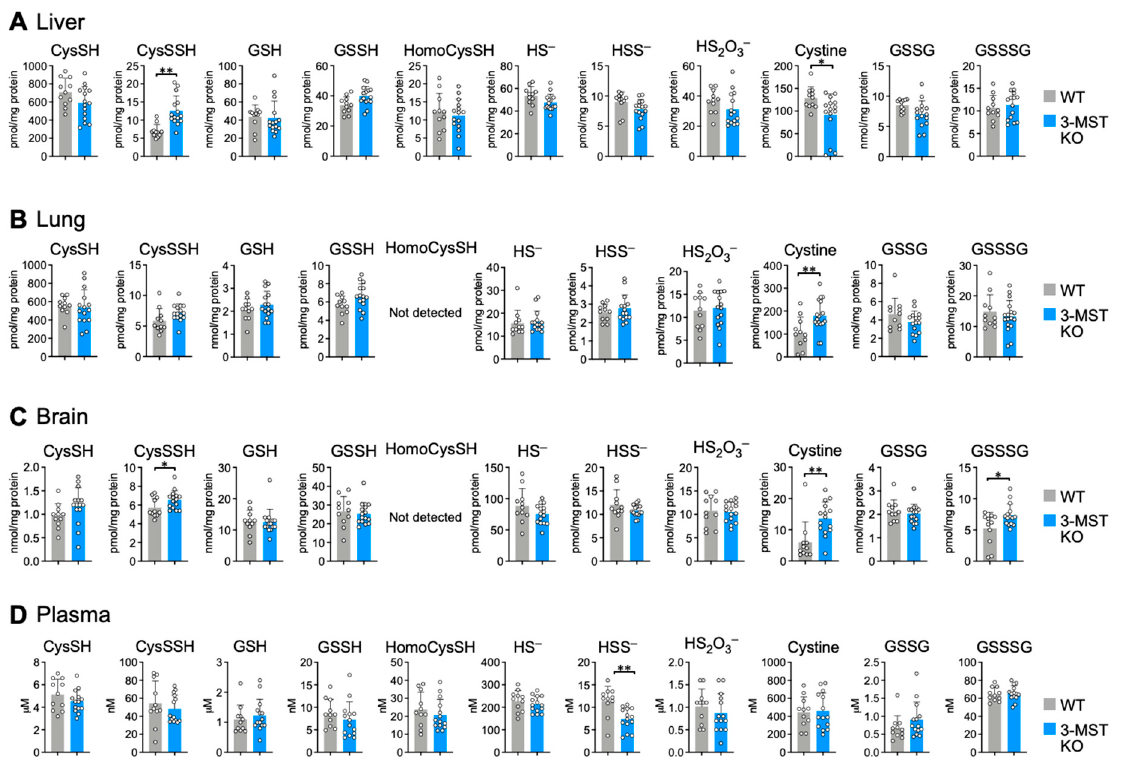
Figure 2. Sulfur metabolome analysis in 3-MST KO mice. Endogenous production of CysSSH, GSSH, and related compounds was identified by means of HPE-IAM labeling with LC–MS/MS analysis of the liver ( A ), lung ( B ), brain ( C ), and plasma ( D ) obtained from 8- to 10-week-old WT and 3-MST KO mice. Data are means ± s.d. n = 11 (WT) and 15 (3-MST KO). * p < 0.05; ** p < 0.01, as determined by Student’s t